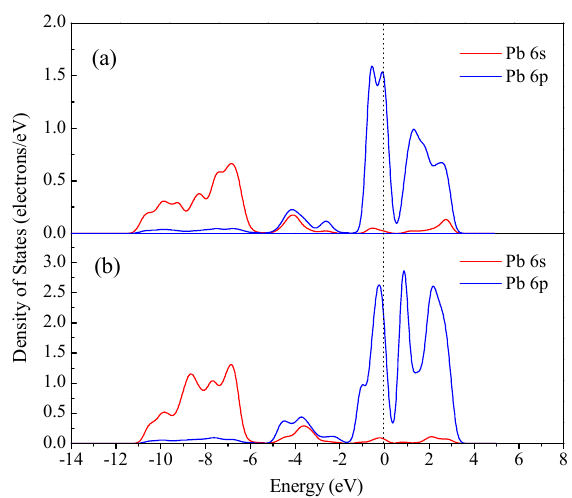
Figure 8. Density of state of Pb atoms for perfect cerussite surface: ( a ) before; ( b ) after PbCl + adsorption.